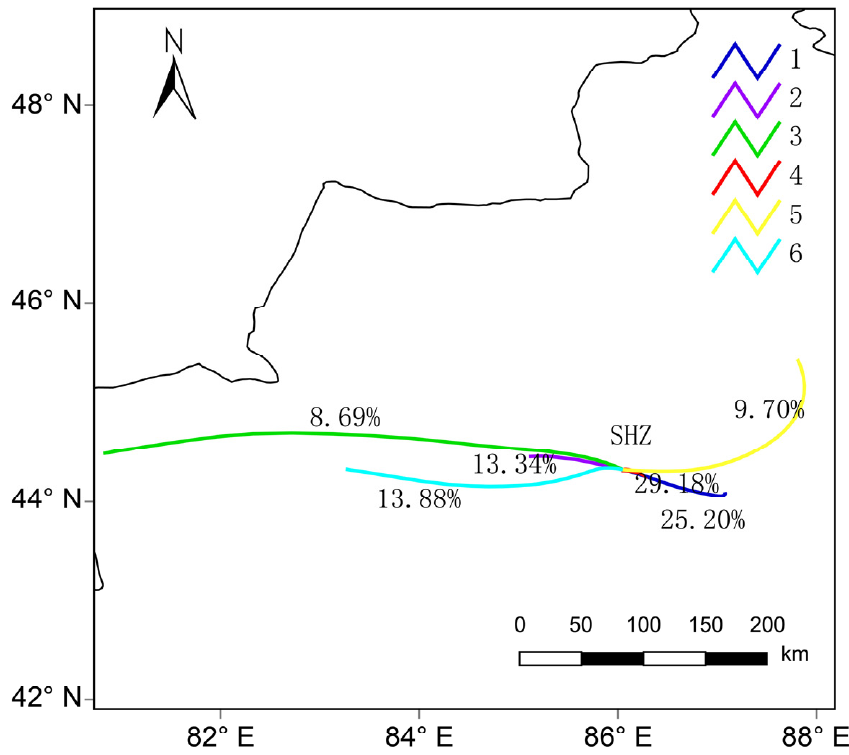
Figure 8. Clustering analysis of the 24 h backward trajectories in Shihezi City in winter. Table 2. The mean concentrations of PM 2.5 in different trajectories.